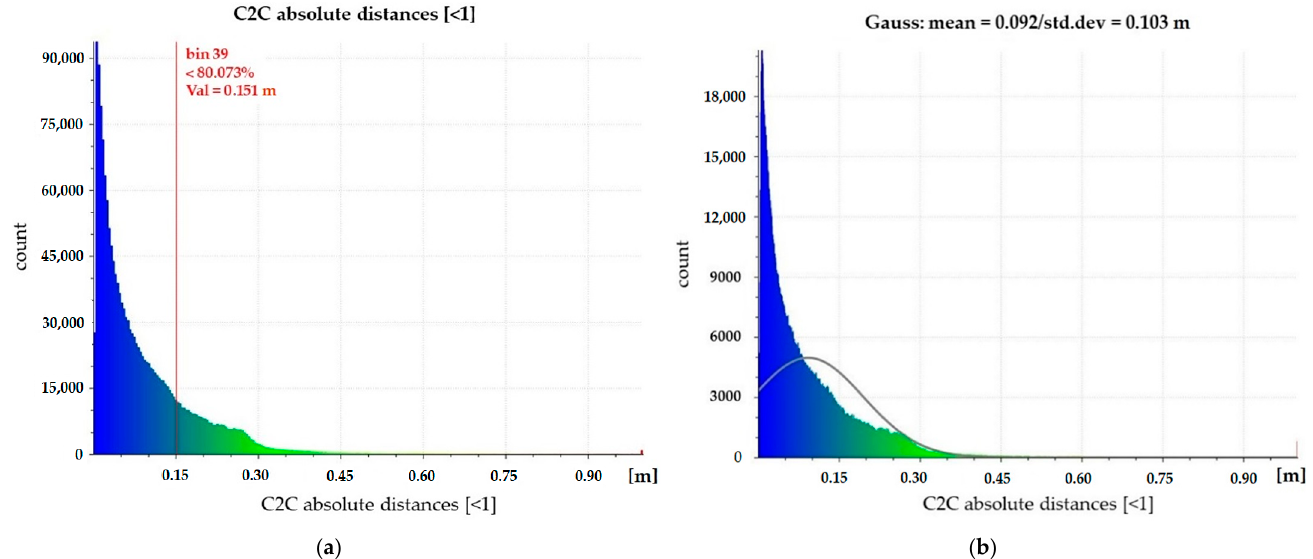
Figure 5. C2C comparison between photogrammetric and TLS data: C2C ( a ) and Gauss distribution ( b ).